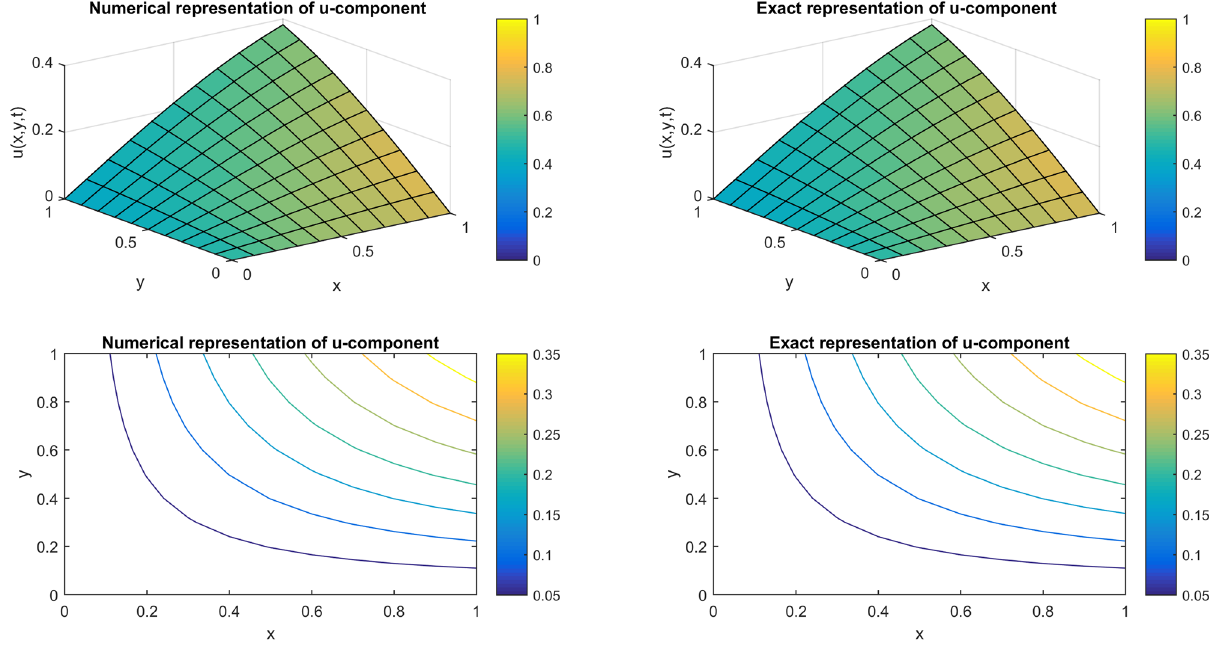
Figure 10: Surface and contour representation of ( ) u x t , at = t 1 with = N 11 , = α 1 , = β 1 , = τ 0.5 , and = t Δ 0.0001 using Method II regarding Example